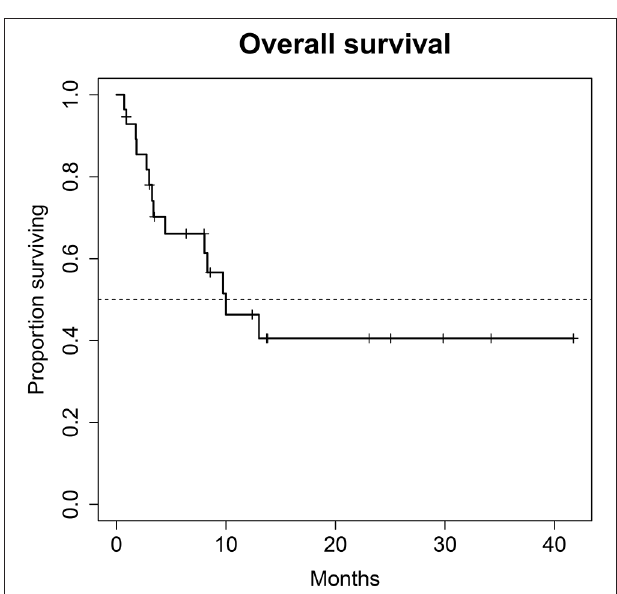
FIGURE 2 | Overall survival (OS) for 28 patients under second line therapy with checkpoint inhibitor monotherapy for metastatic urothelial